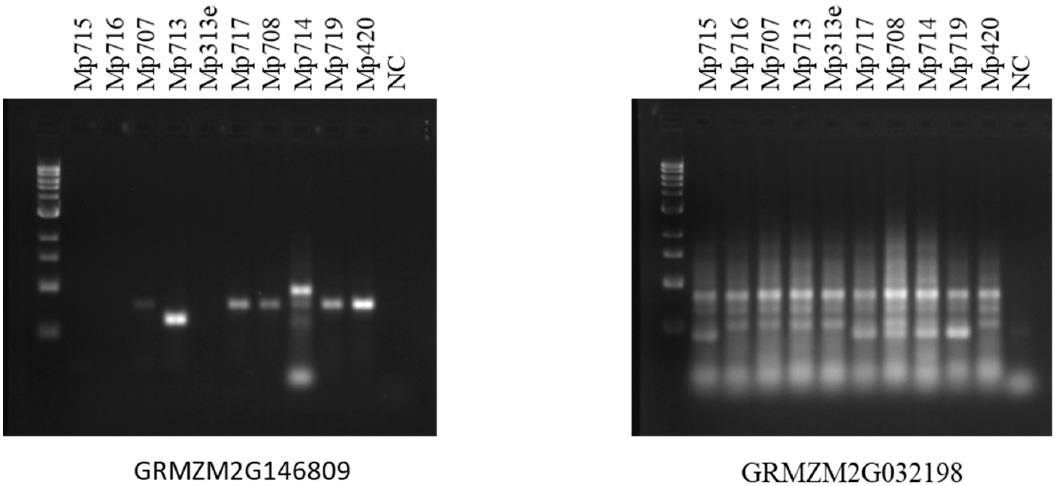
Figure 5. An agarose gel image showing DNA polymorphisms for two maize AMP genes. Gene specific DNA markers were designed for the differentially expressed maize AMPs from maize genomic DNA in order to promote marker-assisted breeding application. DNA polymorphisms were observed among the 10 maize inbred lines in defensin GRMZM2G146809 and cyclotide GRMZM2G032198.